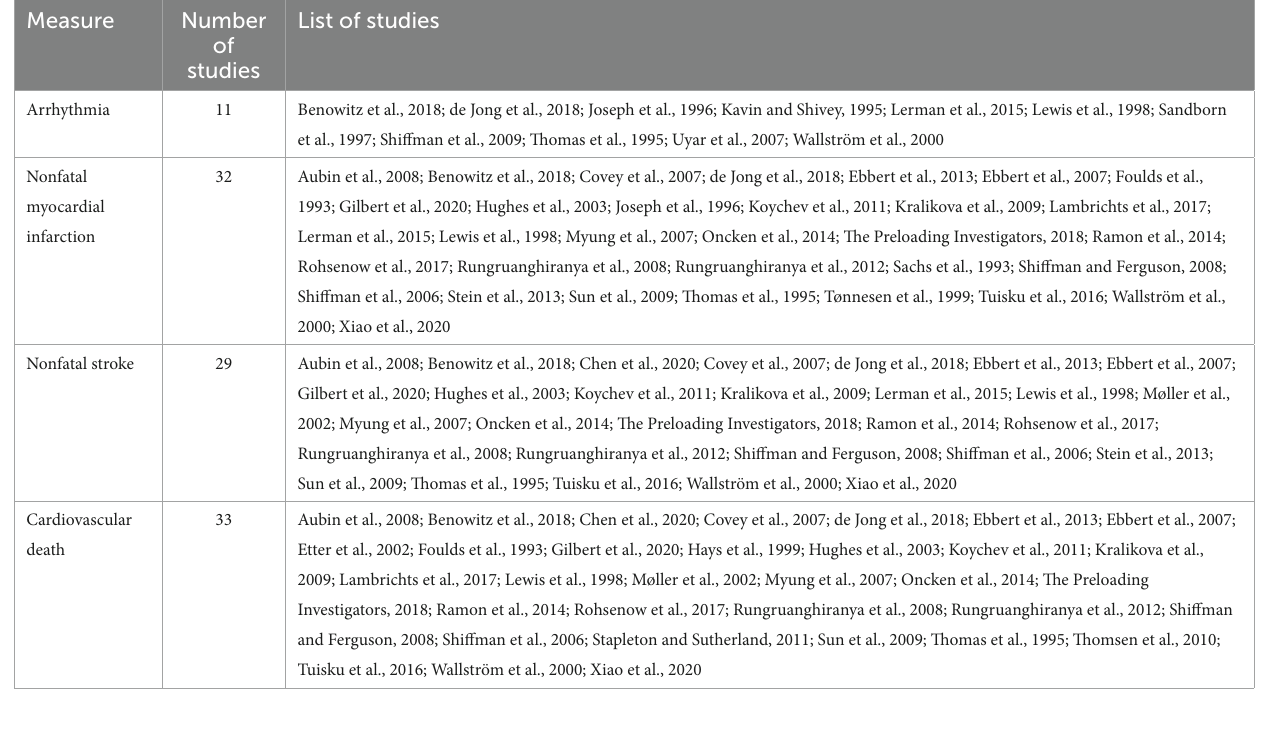
TABLE 2 Number of studies according to outcome measures.